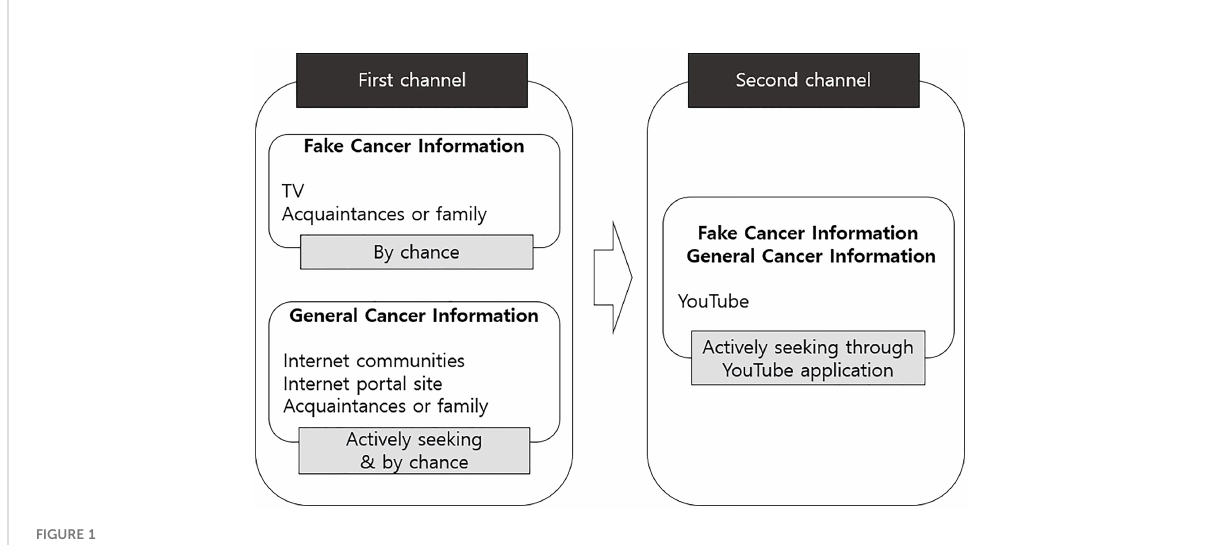
FIGURE 1 The process of acquiring cancer